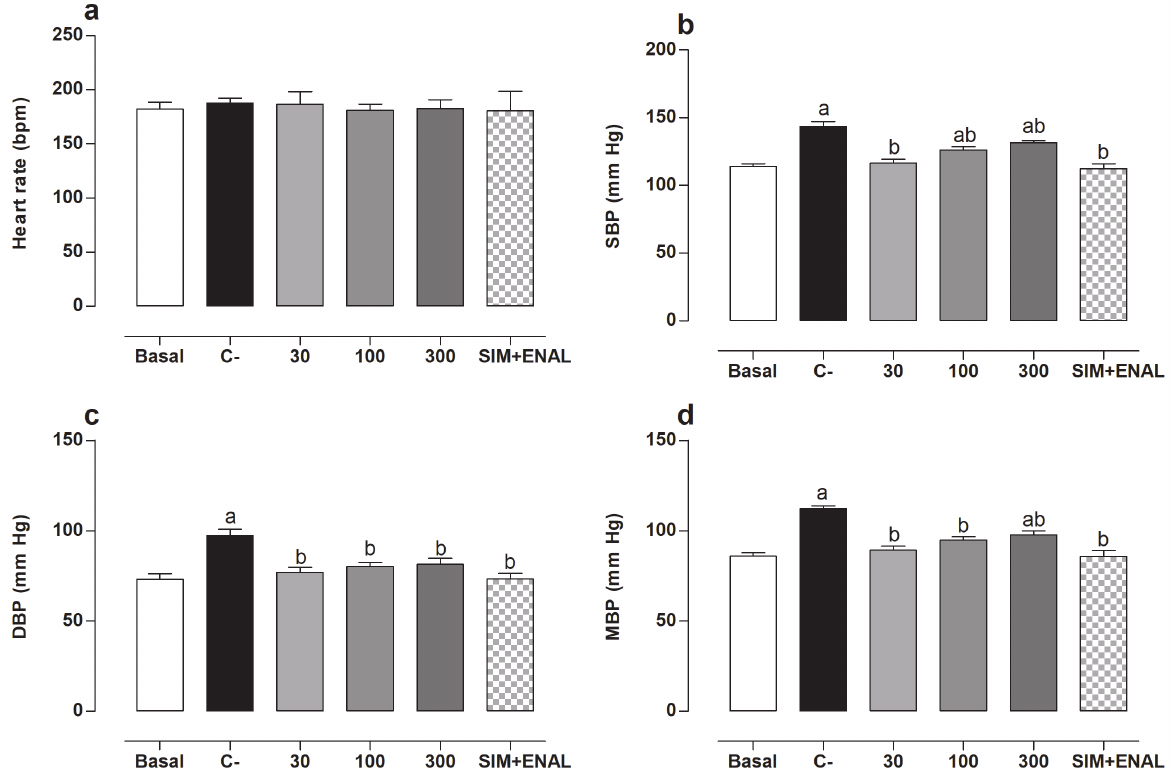
Figure 1. Heart rate (a) , systolic blood pressure (b) , diastolic blood pressure (c) , and mean arterial pressure (d) in normotensive, non-dyslipidemic, and non-smoker Wistar rats (basal group) and hypertensive, dyslipidemic, and smoker Wistar rats that were treated with vehicle (negative control [C–]), Baccharis trimera (30, 100, and 300 mg/ kg), and simvastatin + enalapril (SIM+ENAL). n = 8/group. The data are expressed as mean ± SEM. a p < 0.05, vs . basal; b p < 0.05, vs . C– (Kruskal-Wallis test followed by Dunn’s post hoc test). bpm, beats per minute; SBP, systolic blood pressure; DBP, diastolic blood pressure; MAP, median arterial